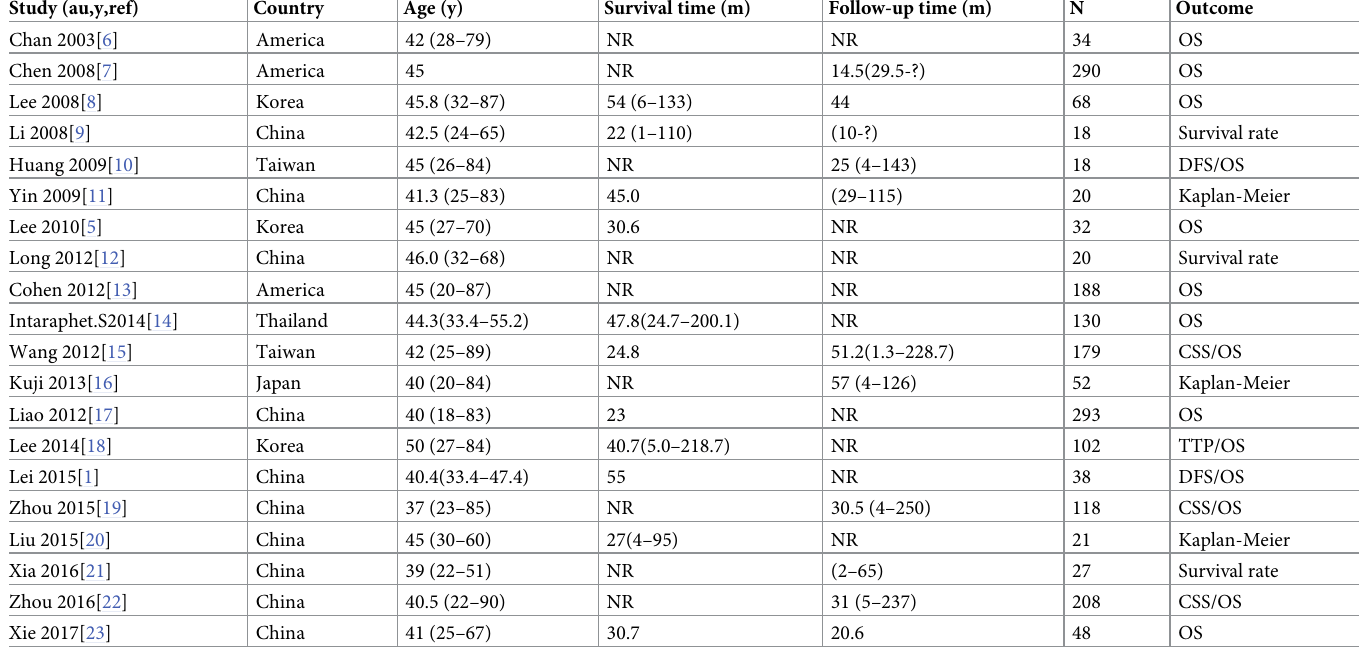
Table 1. Studies included in the